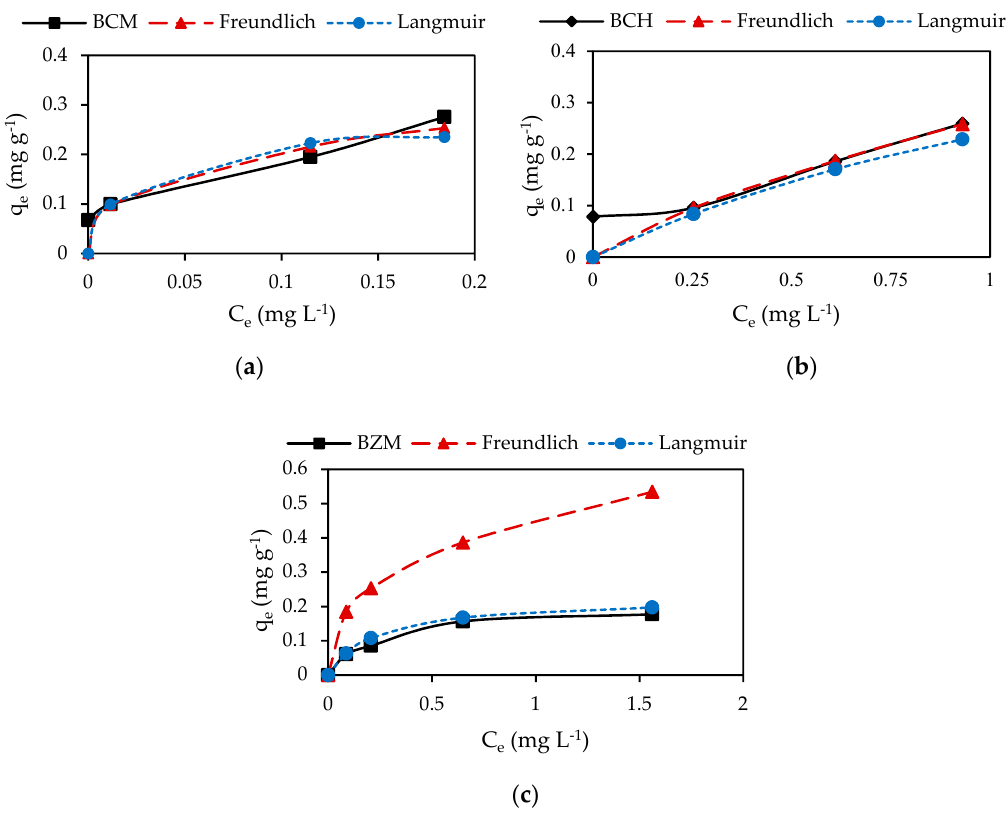
Figure 6. Adsorption Pb 2+ isotherms: ( a ) BCM, ( b ) BCH and ( c ) BZM